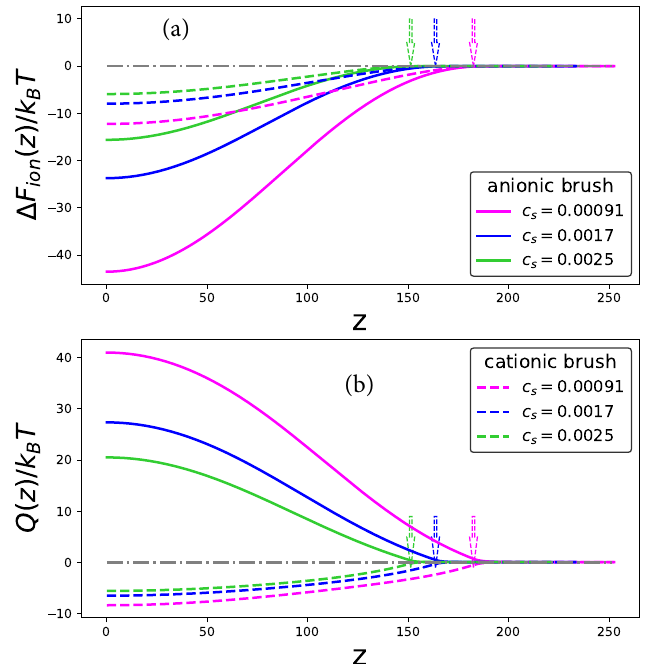
Figure 3. Dependences of the re-ionization free energy ∆ F ion ( z ) ( a ) and net charge of the BSA globule ( b ) on the distance from the grafting surface z for the cases of polyanionic (solid lines) and polycationic (dashed lines) brushes at the IEP. The color code corresponding to different salt concentrations C s is indicated in the legend. Other parameters are pH b = pI = 5.25, s = 100, N = 300. Arrows indicate the upper boundary of the brush ( z = H ).